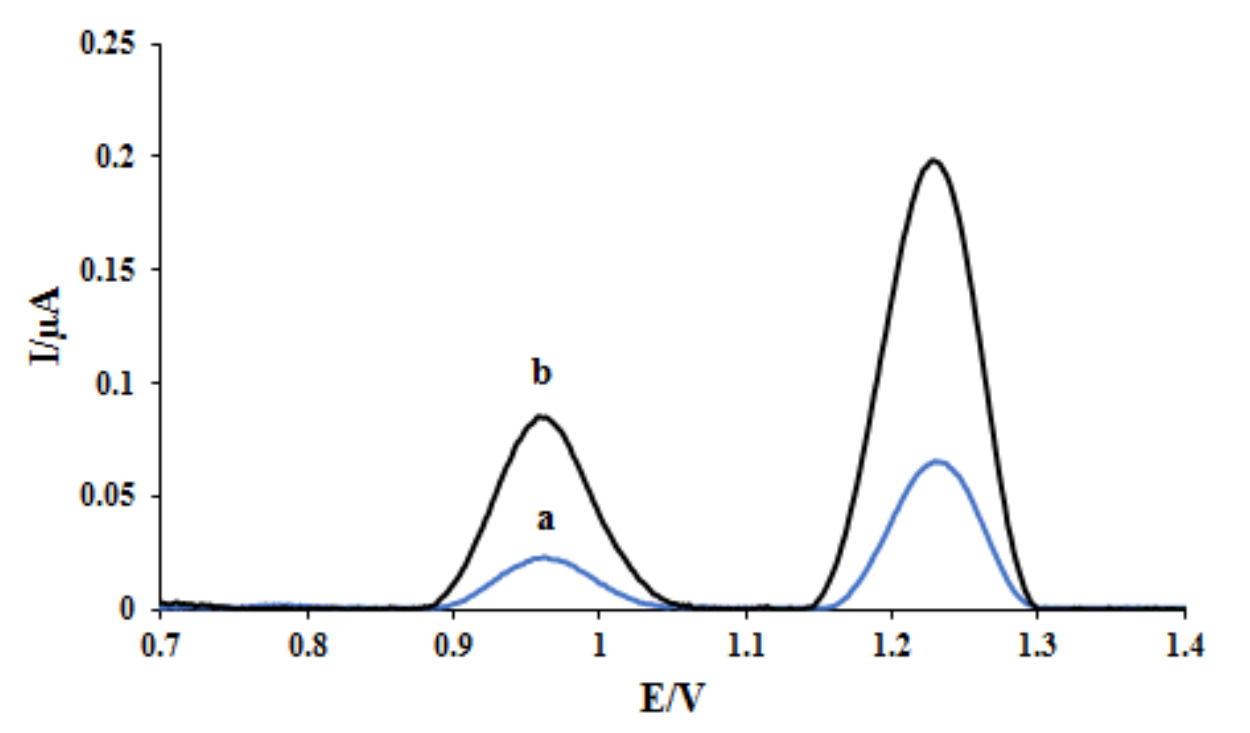
Figure 1. DPVs of (a) DNA/GCE and (b) DNA/rGO/GCE in pH 4.7 acetate buffer.